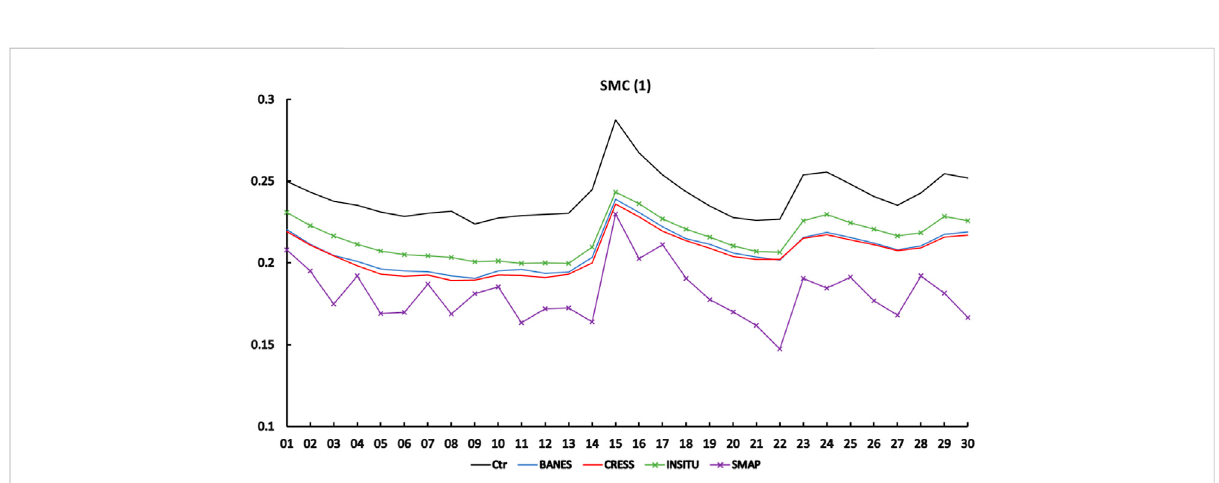
Frontiers in Earth